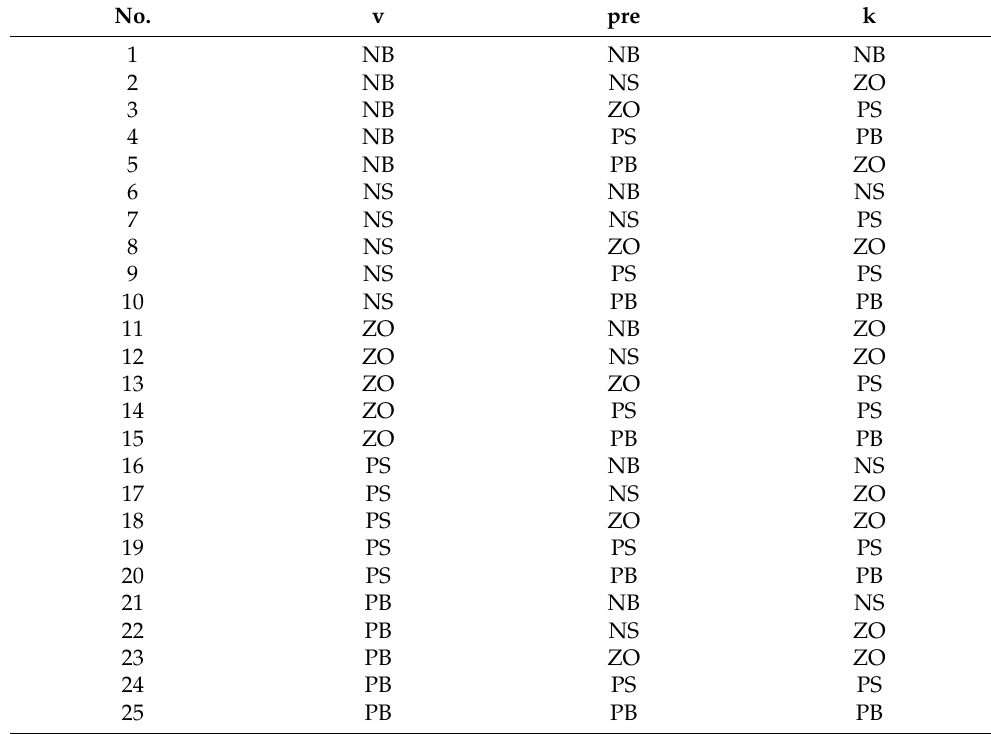
Figure 13. Fuzzy optimization analysis: torque curve. Figure 14 demonstrates the comparison of the battery SOC. It can be seen from the figure that the battery SOC is almost the same under the two control strategies. Actually, the battery SOC under the fuzzy control strategy is 84.2073%, and that with rule-based control strategy is 84.2070%. The optimized control strategy has a slight improvement on the battery SOC.